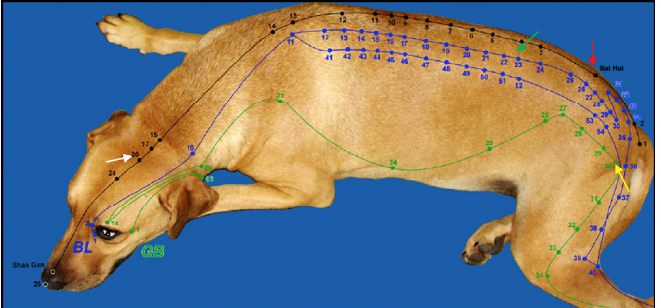
Figure 1. Meridians with Acupoints. Green is Gall Bladder (GB) Meridian, Blue is Bladder (BL) Meridian and Black is Governing Vessel (GV). GV-20 = White Arrow, Bl-23 = Green Arrow, Bai-Hui = Red Arrow, GB-30 = Yellow arrow. (Reprinted with permission from Ref [2]. 2003, H. Xie).